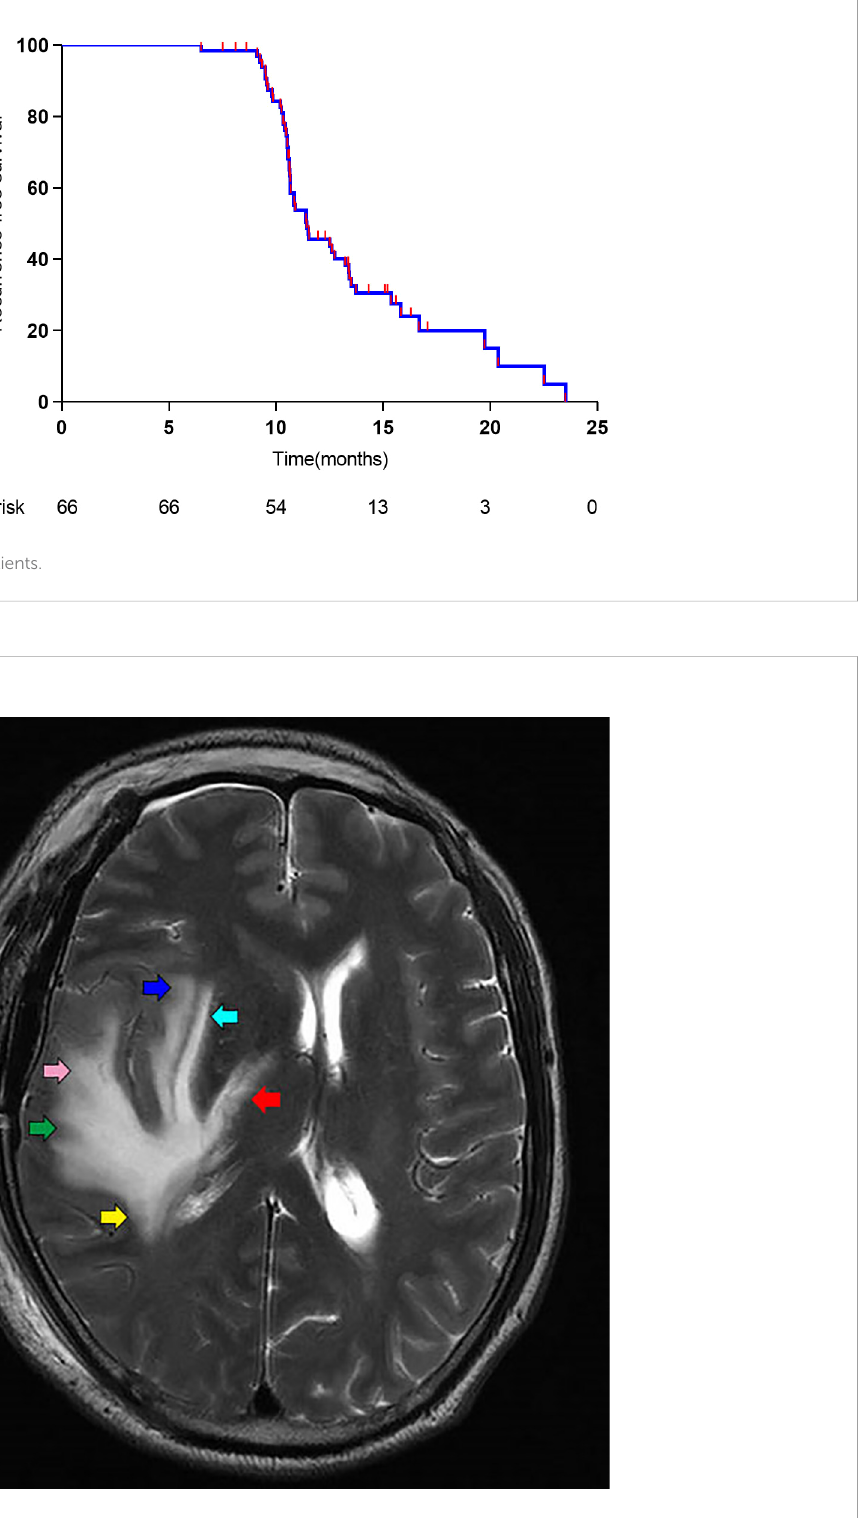
FIGURE 5 Different parts of edema is the representation of different nerve fi ber bundles: Arcuate fi ber (green arrow), inferior longitudinal fasciculus (pink arrow), external capsule (light blue arrow), Posterior limb of internal capsule (red arrow), tapetum of corpus callosum (yellow arrow), and extreme capsule (blue arrow).